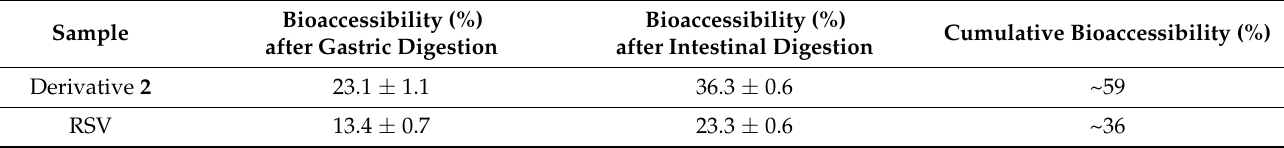
Table 1. Bioaccessibility (%) of derivative 2 and